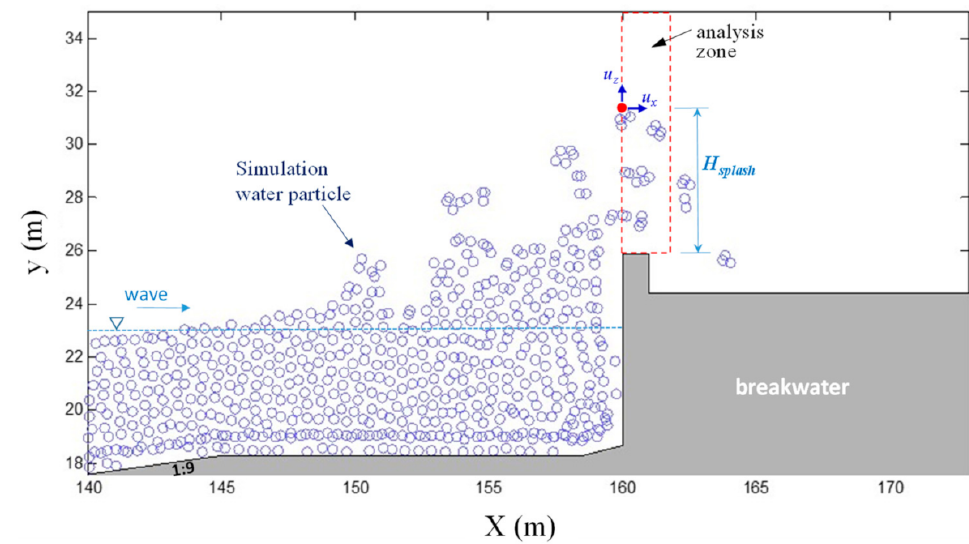
Figure 4. Layout of the model setup and the definition of overtopping